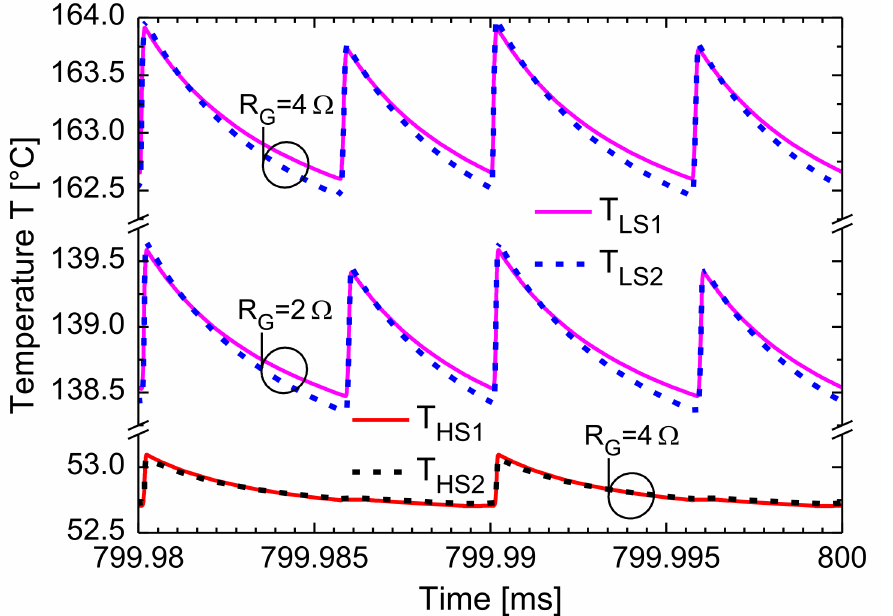
Figure 9. SIMetriX simulation of the macrocircuit representing the DC-DC converter: temperature of the four VDMOS transistors (averaged on the active area) vs. time in a two-period-long window at the limit cycle. Also reported is the temperature evolution of the LS devices obtained by reducing the gate resistance R G from 4 Ω (default value) down to 2 Ω